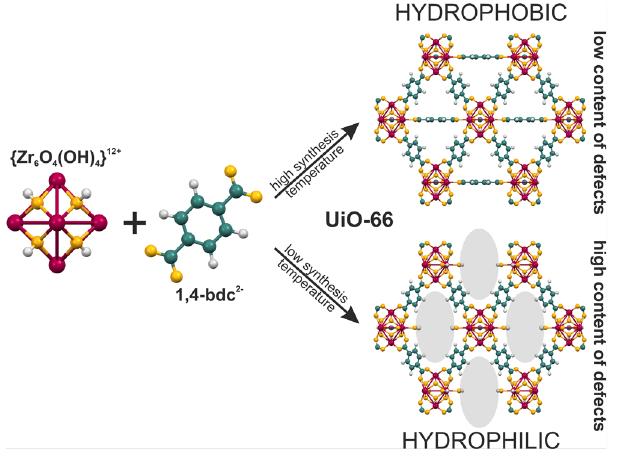
Fig. 1 UiO-66 structure with different content of defects. Schematic representation of the in fl uence of the synthesis temperature on the number of defects introduced into the structure and its dependence on the nature of the material.